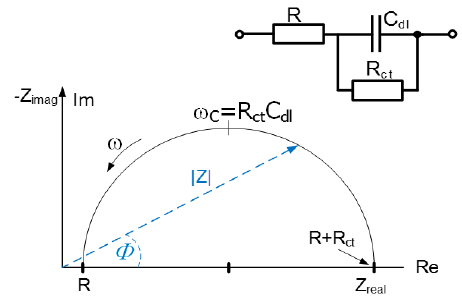
Figure 5. The impedance spectra of the reference and treated water samples.